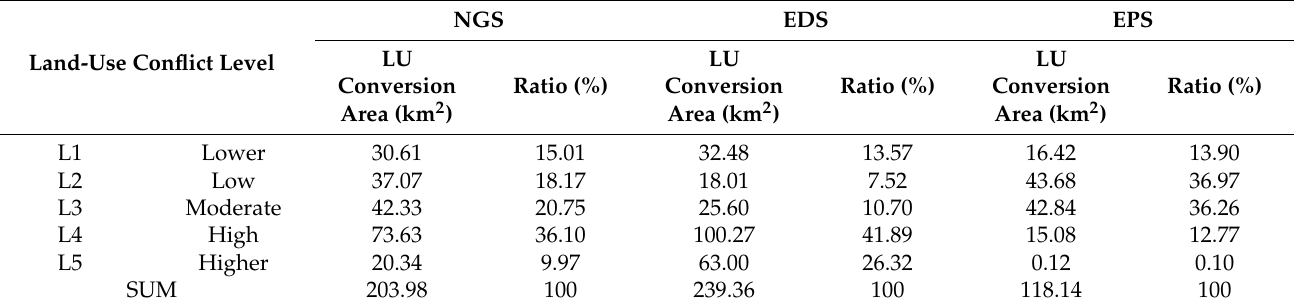
Table 6. Land use conversion area at each LUC level under different